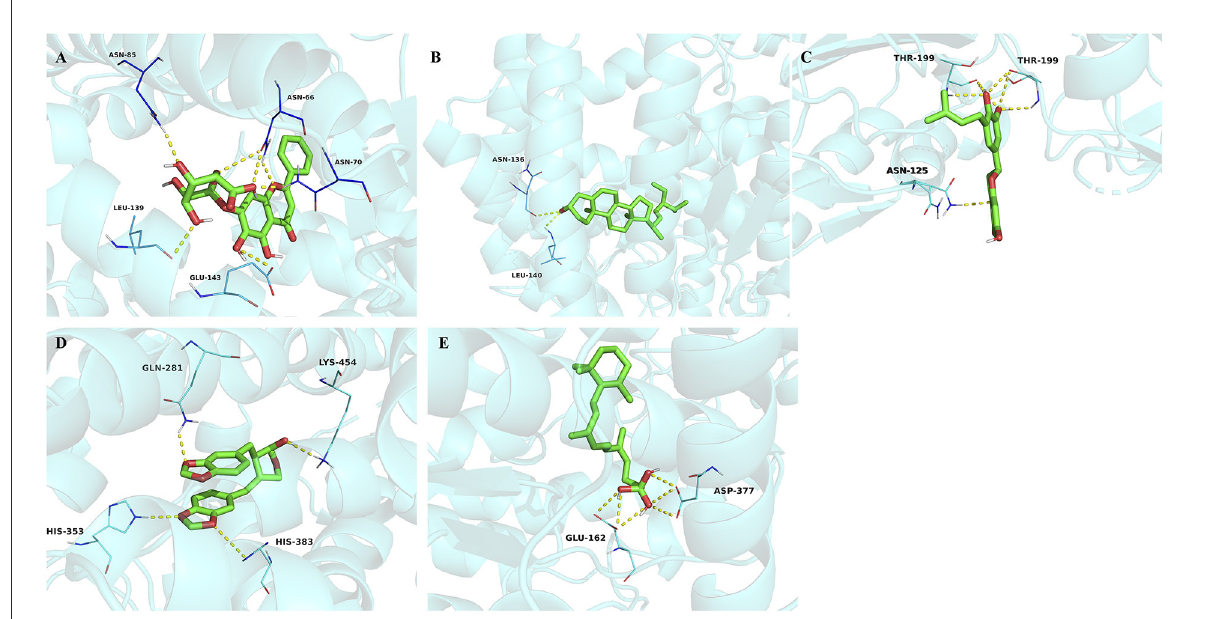
FIGURE7 (A) Molecular docking of baicalin binding with ACE. (B) Molecular docking of stigmasterol binding with ACE. (C) Molecular docking of sigmoidin-B to caspase-6. (D) Molecular docking of cubebin binding with ACE. (E) Molecular docking of troxerutin binding with ACE. The yellow dot lines indicate the hydrogen